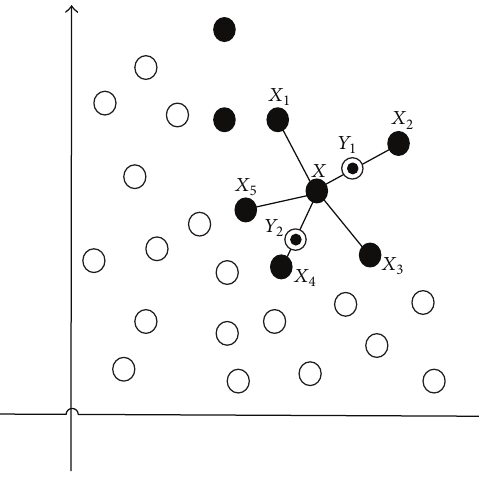
Figure 1: Schematic diagram of SMOTE algorithm. samples, 𝑥 𝑖 stands for these chosen neighbor samples and New Sample stands for the new generated samples.